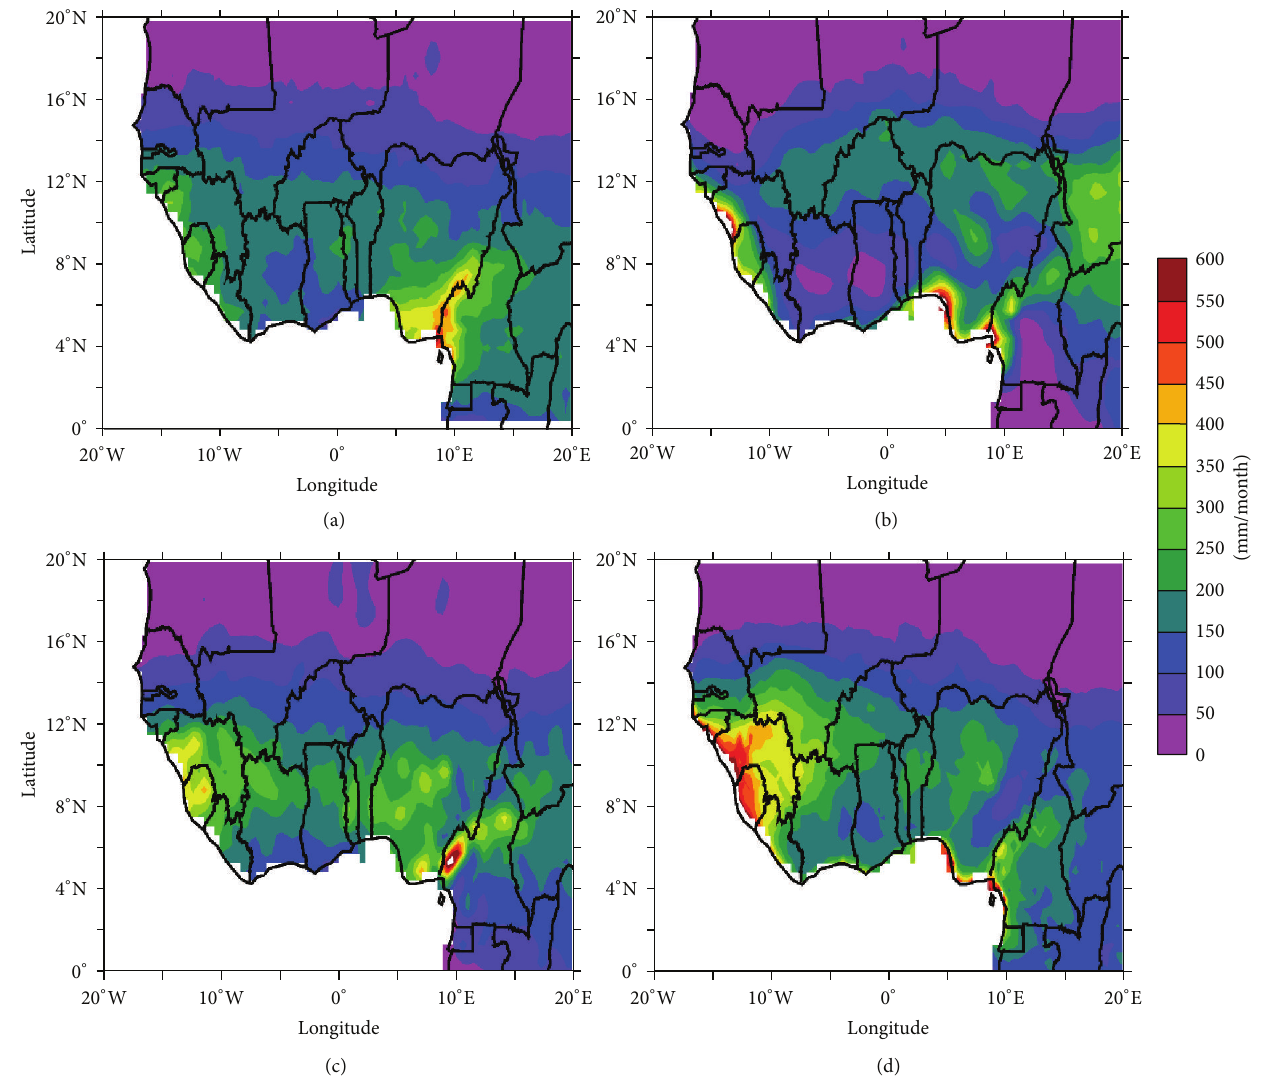
Figure 4: Spatial pattern of mean monthly JJAS precipitation (mm/month) for (a) TRMM, (b) CCLM, (c) RCA, and (d) REMO from 1998 to 2008.